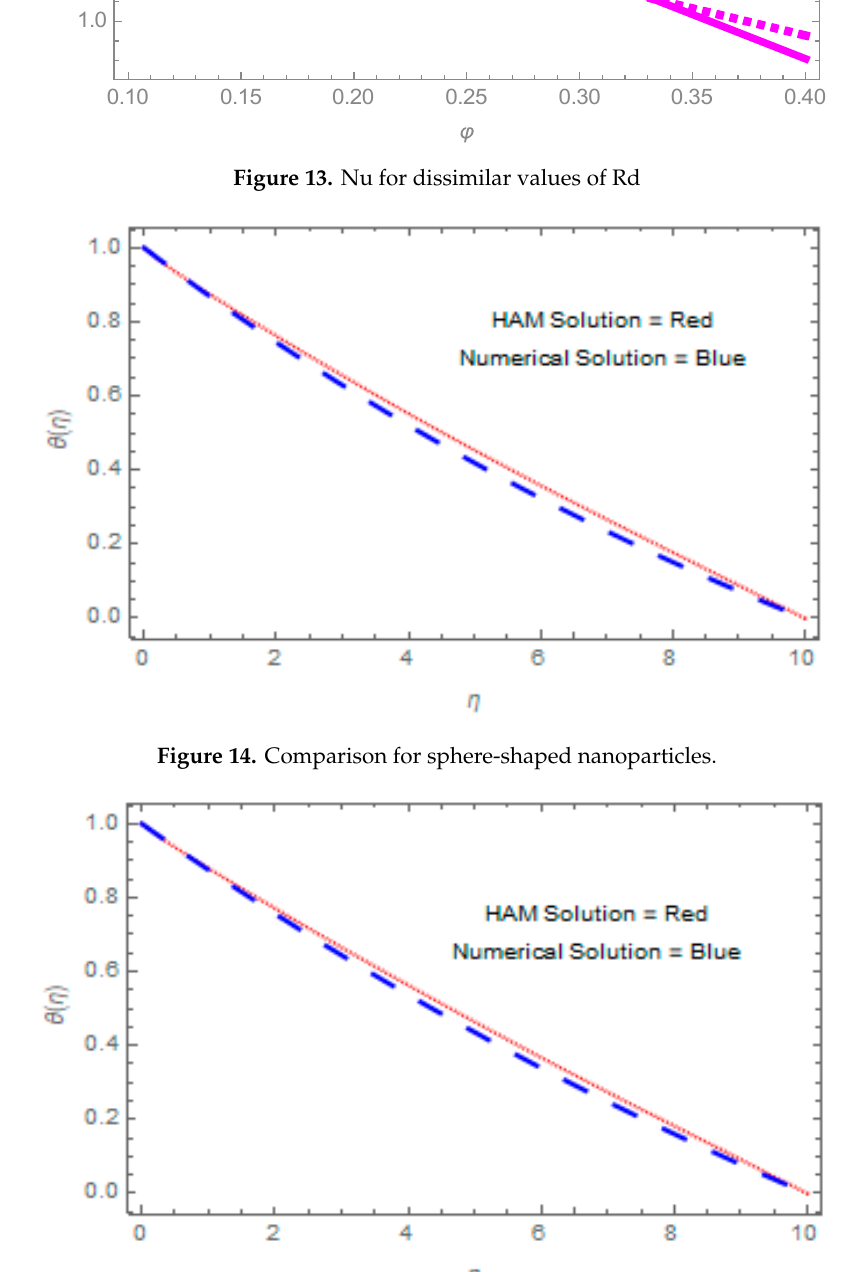
Figure 15. Comparison for platelet-shaped nanoparticles .